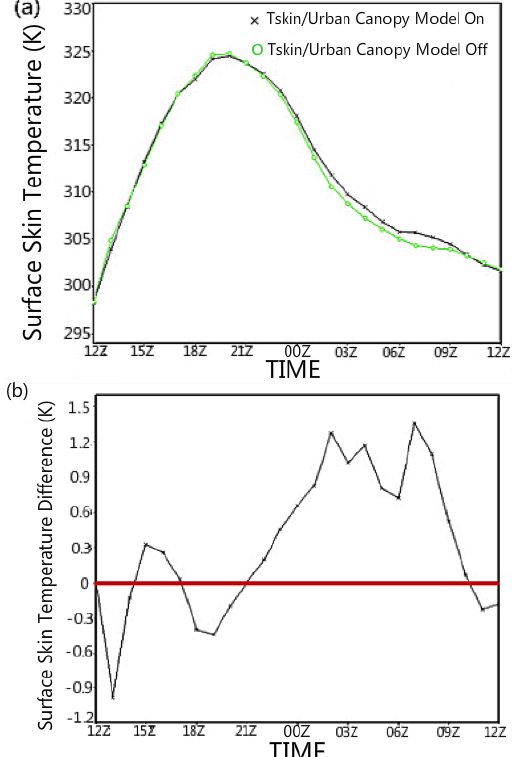
Figure 12. ( a ) The WRF model simulated skin temperature (T skin ) for the sensitive run and control run in urban regions in OKC. The green curve is for the control run (i.e., T skin with urban canopy model off in the WRF simulation), and the black curve is for the simulation of the sensitive run (i.e., T skin with urban canopy model turned on in WRF simulation); ( b ) Skin temperature difference between the sensitive run and control run (sensitive run minus control run) in urban regions in OKC. Temperature and temperature difference are in K.